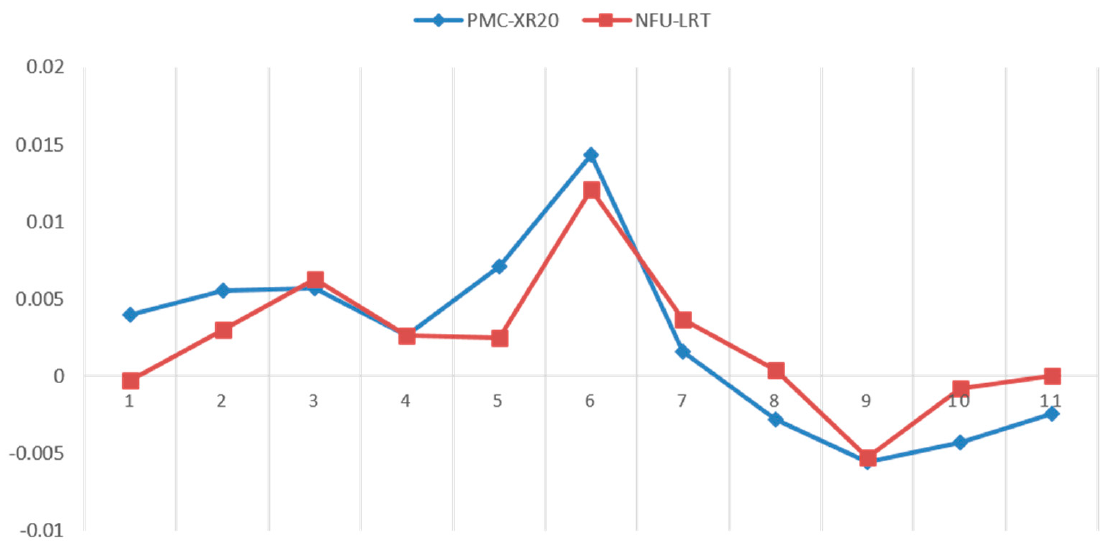
Figure 28. Comparison of the error result between two systems.